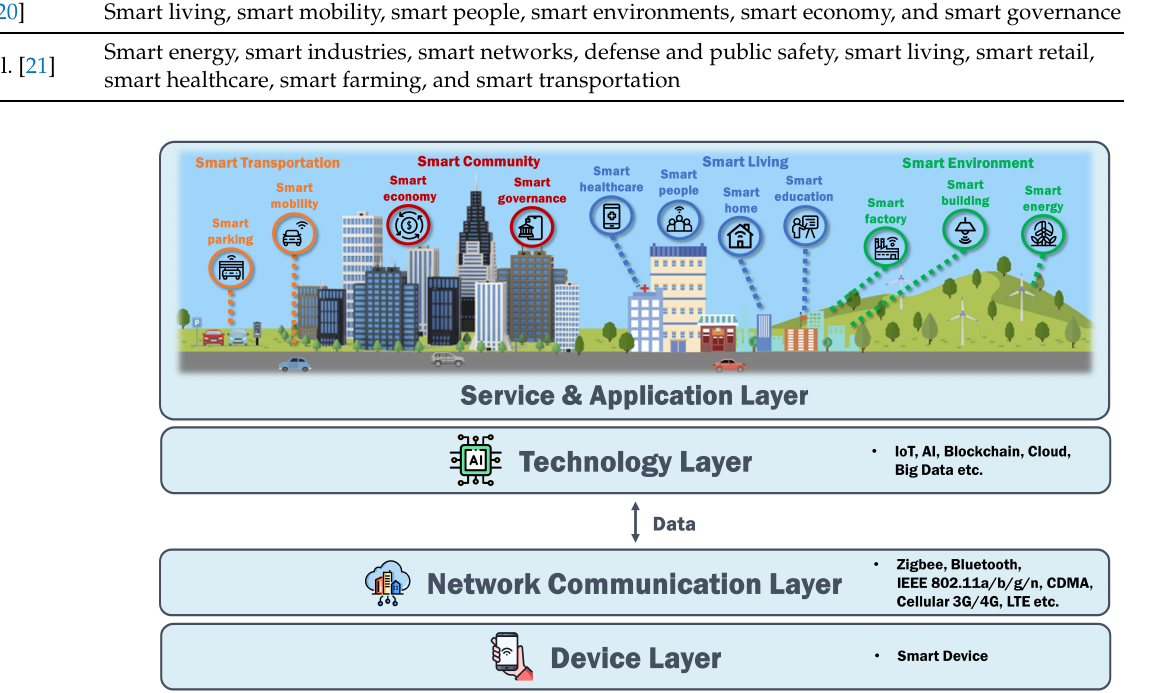
Figure 1. The architecture of smart cities. All elements were identified by the authors. The layers and area icons of smart cities were made using Freepik, orvipixel, Mayor Icons, Barudaklier, and KP Arts from www.flaticon.com, accessed on 29 March 2023